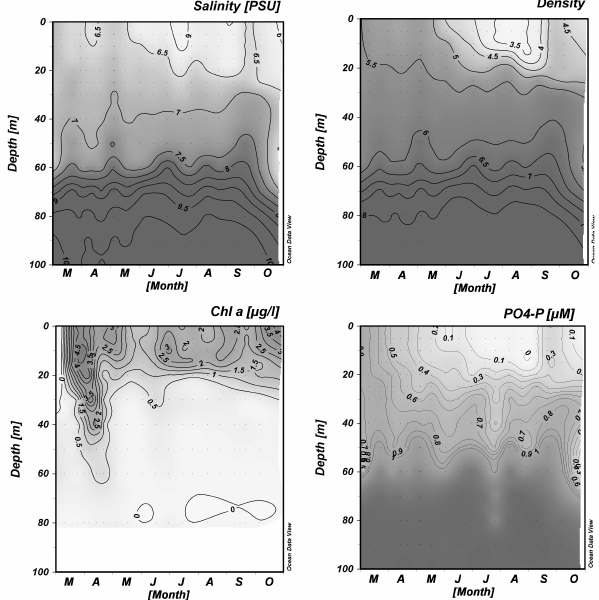
Fig. 7. Time series of salinity, density, chl- a and PO 2 − 100m at the Landsort Deep station (BY31) during 2004. This figure was prepared with Ocean Data View using DIVA